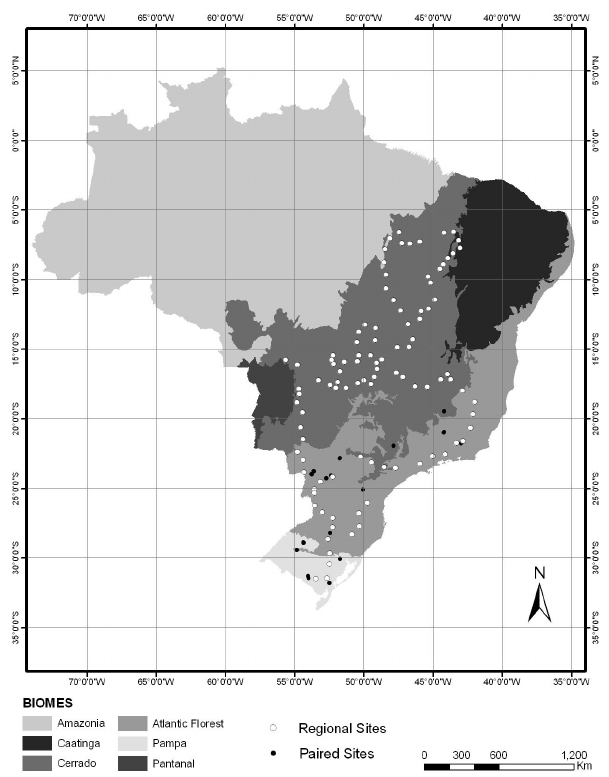
Fig. 1. Sampling sites distributed throughout Brazil. Open circles indicate pasture sites of the regional survey; closed circles indicate paired study sites, and gray shadows, Brazilian